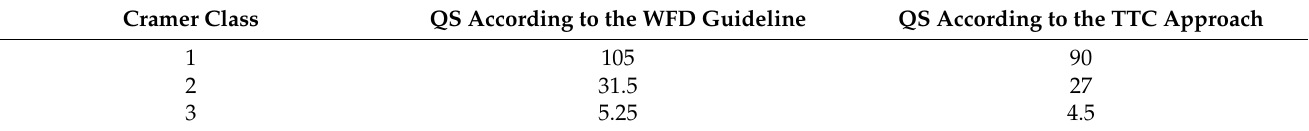
Table 2. The hTTC-derived Quality Standards (QS) obtained with the proposed approach. Values are µ g/L. Cramer Class QS According to the WFD Guideline QS According to the TTC Approach 1 105 90